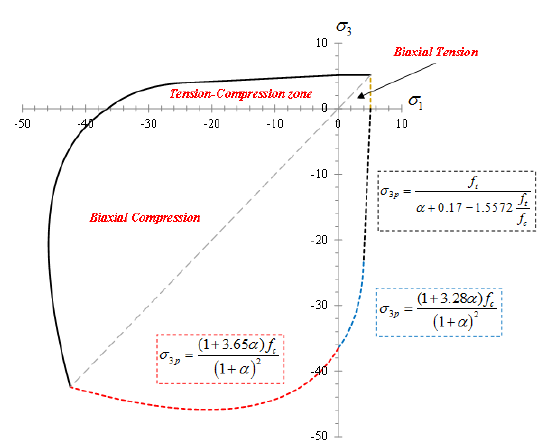
Figure 20. Biaxial failure envelope of the concrete